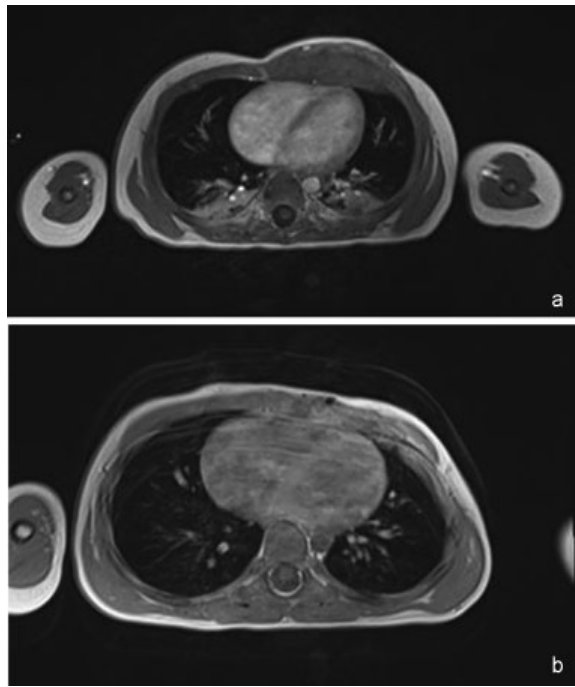
Fig. 3 MRI scans of patient A. (a) Tumor at the age of 9 months. (b) Tumor site 24 months postoperatively without recurrence. MRI, magnetic resonance